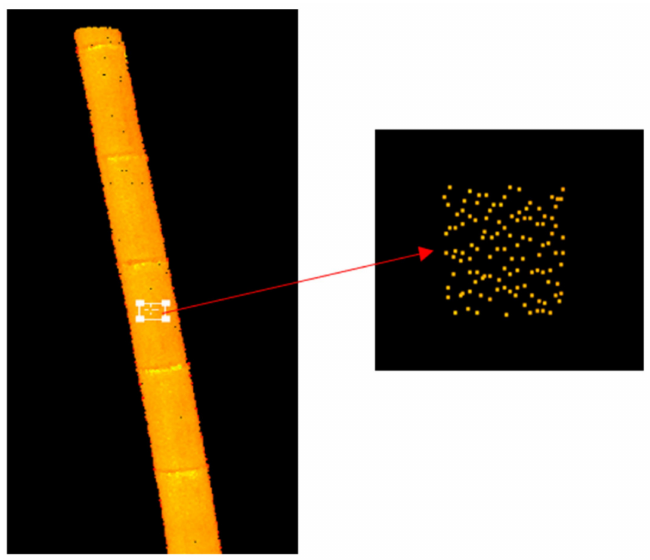
Figure 5. Extraction of laser intensity values from a culm